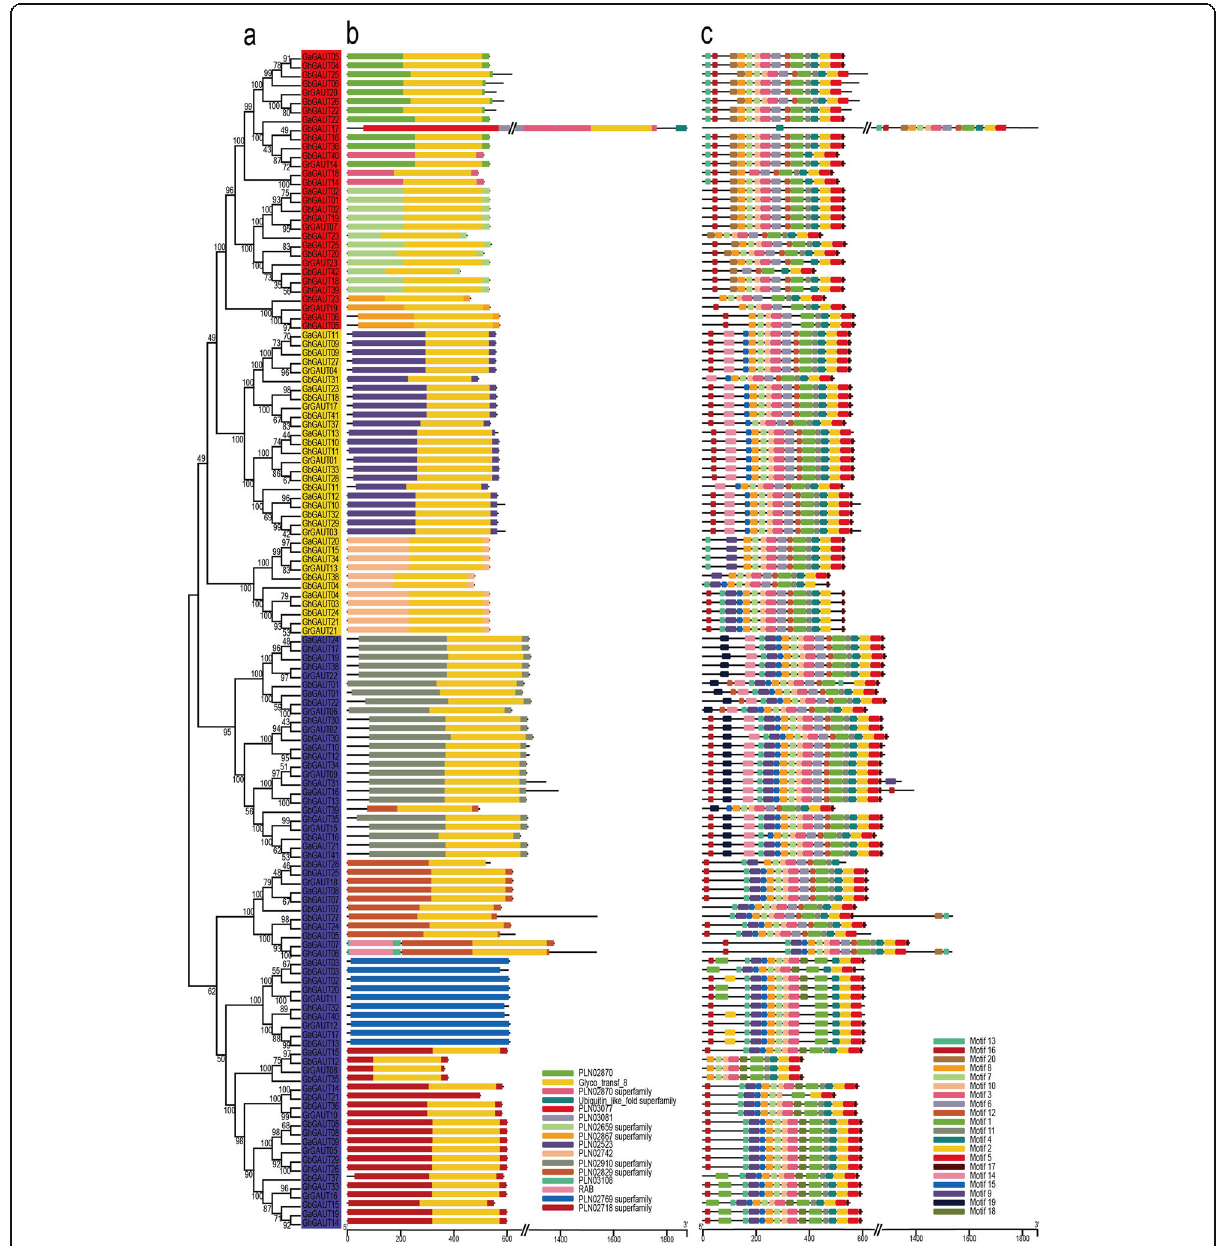
Fig. 2 The stucture analysis of galacturonosyltransferase (GAUT) gene family. a: Phylogenetic tree of the galacturonosyltransferase (GAUT) gene family. b: Analysis of the genomic sequences of the GAUT gene family domains. c: Analysis of the genomic sequences of the GAUT gene family